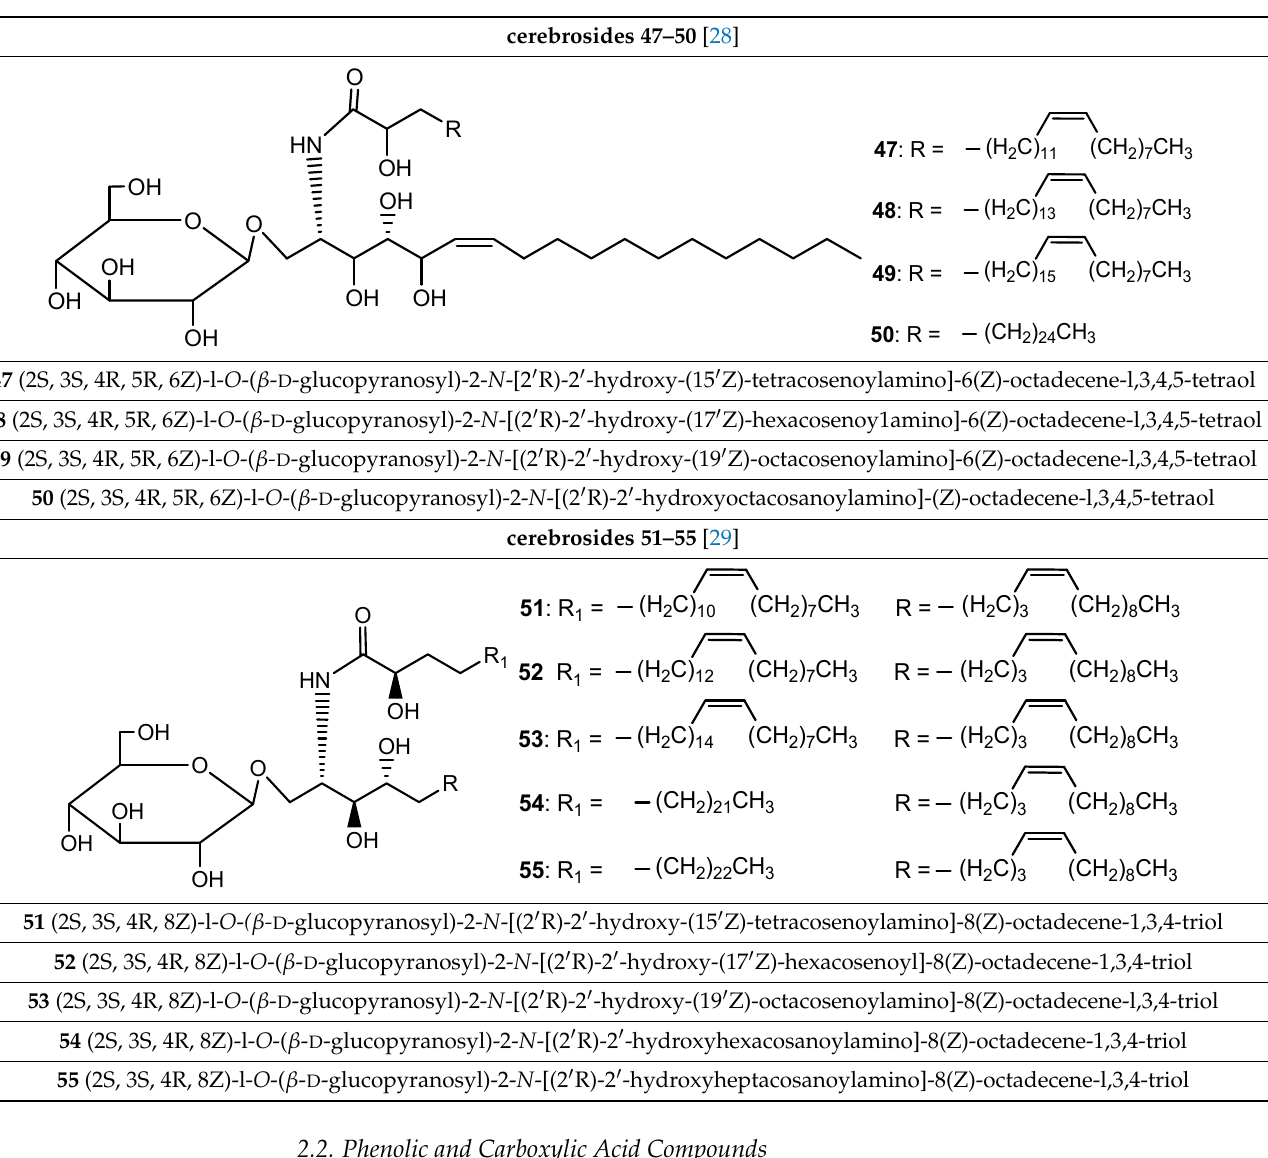
Table 3. Cerebrosides identified from the latex of E. characias (compounds 47 – 55